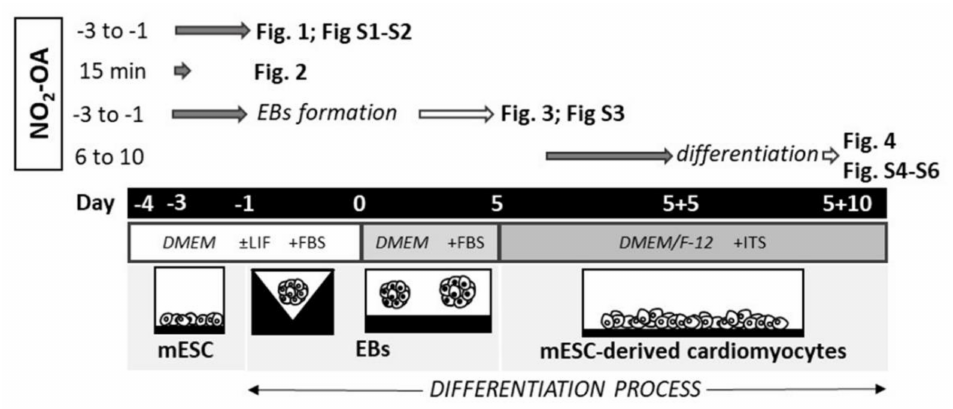
Scheme 1. Overall schematic illustration of the protocol used in the study. Nitro-oleic acid (NO 2 -OA); embryoid bodies (EBs); mouse embryonic stem cells (mESC); leukemia inhibitory factor (LIF); insulin- transferrin-selenium